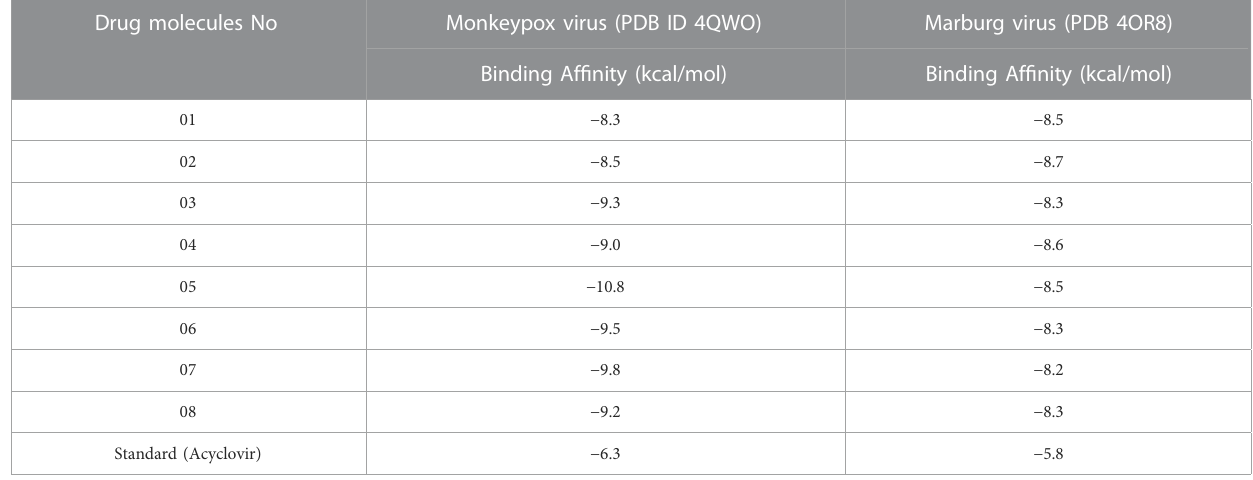
TABLE 4 Binding af fi nities of docked ligand calculated against Monkeypox and Marburg